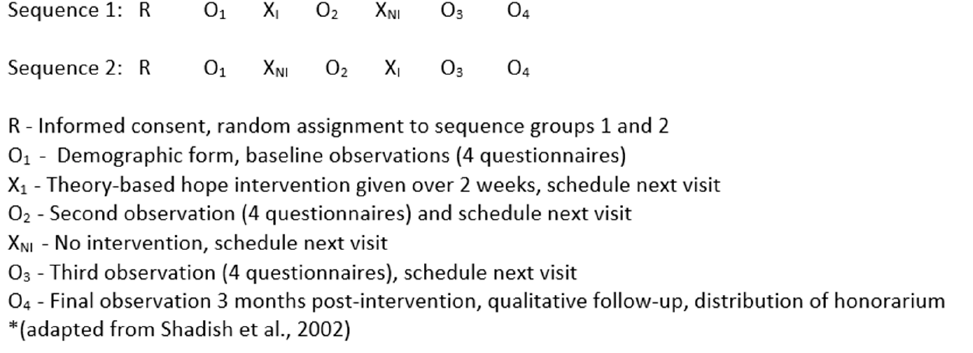
Figure 1. Crossover Design and Research Process.